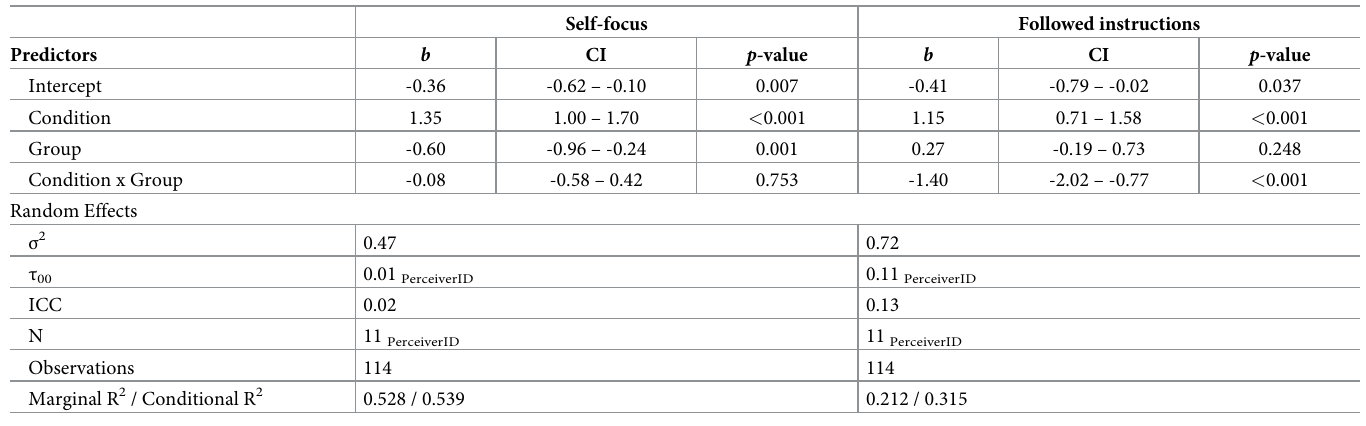
Table 3. Effects of experimental condition and social anxiety group on manipulation checks.